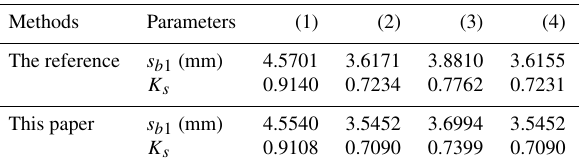
Table 3. Numerical results of tooth profile parameters in the exam- ples by different